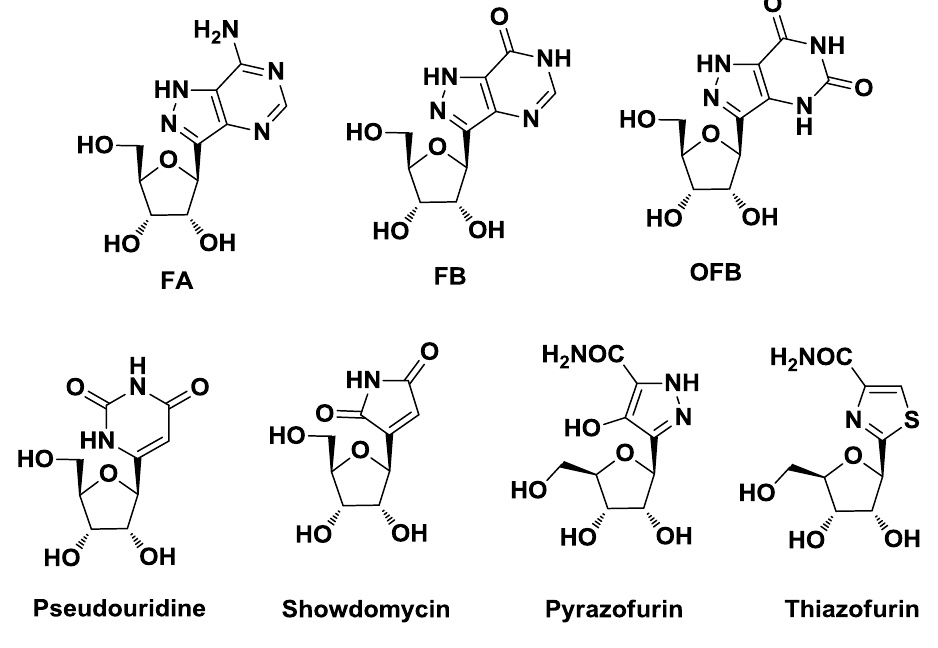
Figure 1. Examples of C